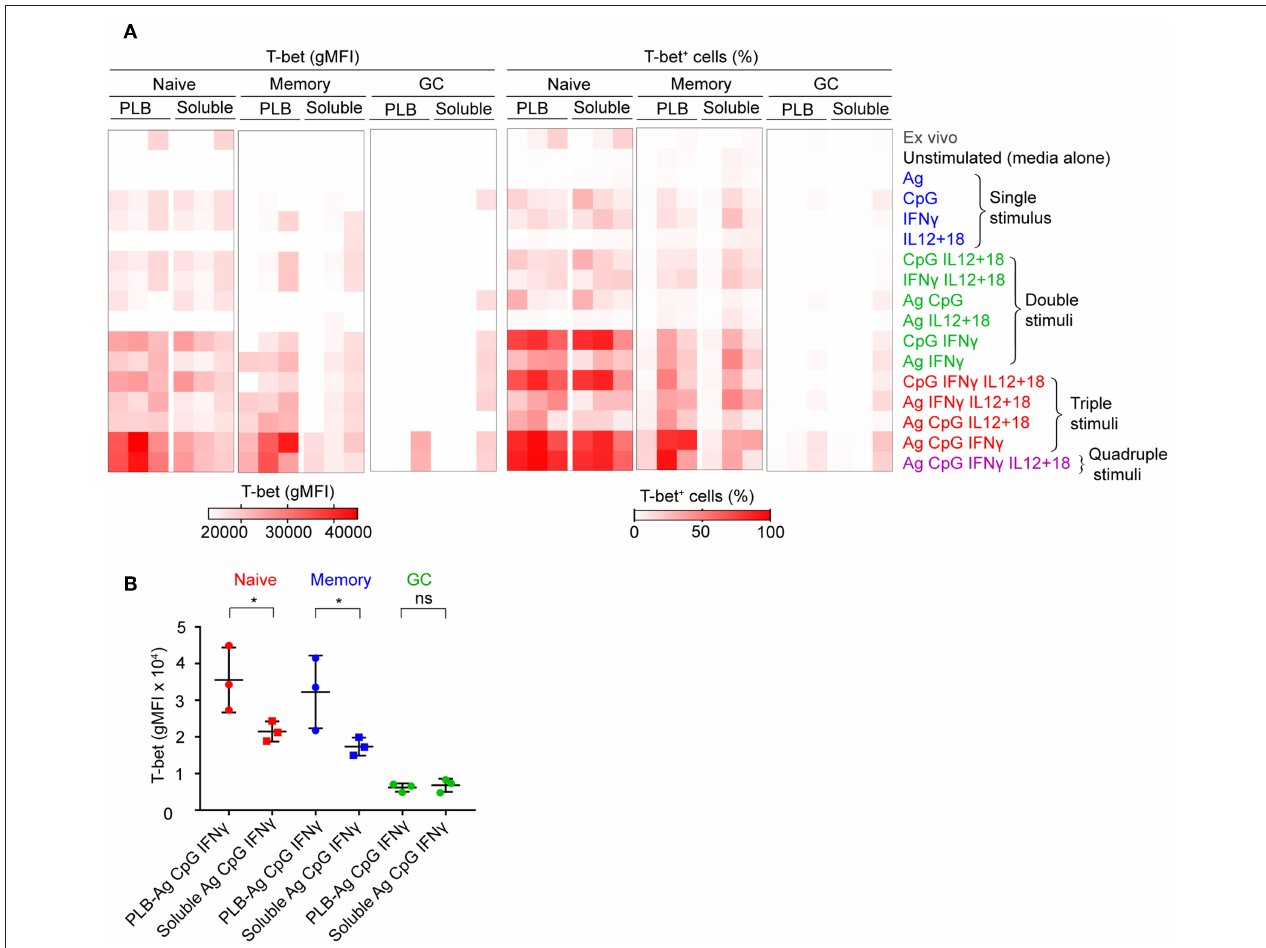
FIGURE 2 | T-bet expression in FACS sorted naïve, memory, and GC B cells upon stimulation in vitro. (A) Tonsil B cells from three individuals were FACS sorted based on IgD and CD10 expression into naïve (CD10 − IgD + ), memory (CD10 − IgD − ), and GC (CD10 + IgD − ) B cells gated as shown ( Figure S1B ) and cultured in vitro as in Figure 1A with either soluble antigen or antigen presented on PLB in the presence of the stimuli shown. T-bet expression was analyzed by flow cytometry and presented as a heat map indicating T-bet expression (gMFI) (left panel) and the percent of B cells expressing T-bet (right panel). The gMFI was calculated for conditions in which a minimum of 5% of the cells were T-bet + . (B) Comparison of T-bet expression (gMFI) by FACS sorted naïve, memory, and GC B cells stimulated in vitro with antigen either attached to PLB or soluble, in the presence of CpG and IFN- γ ( n = 3). Data for T-bet expression (gMFI) by FACS sorted naïve, memory, and GC B cells stimulated in vitro on all stimulation conditions is provided in Supplementary Table 1 . Data were analyzed using paired t test. * P <